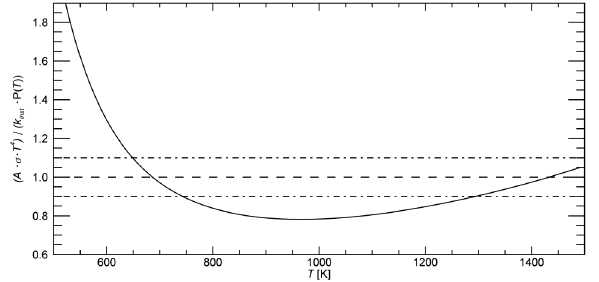
Figure 1. Ratio between the true radiant power and the estimation by Wooster et al. (2003).